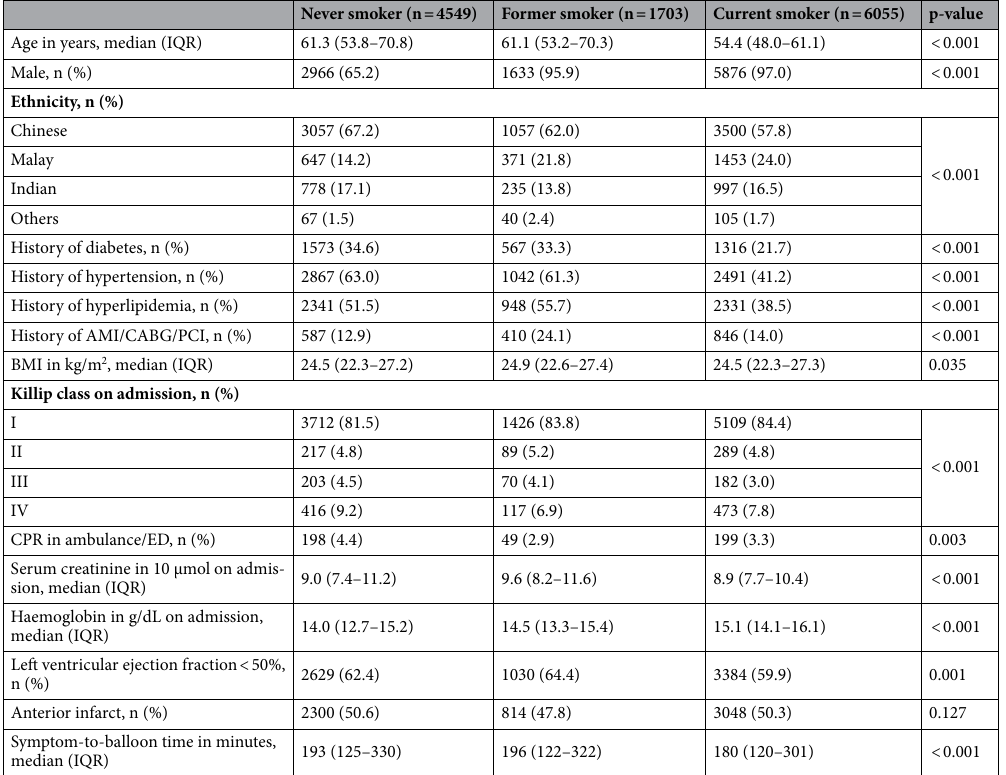
Table 1. Demographic and clinical characteristics of STEMI patients by smoking status. * AMI acute myocardial infarction, BMI body mass index, CABG coronary artery bypass surgery, CPR cardiopulmonary resuscitation, ED emergency department, IQR interquartile range, PCI percutaneous coronary intervention, STEMI ST-elevation myocardial